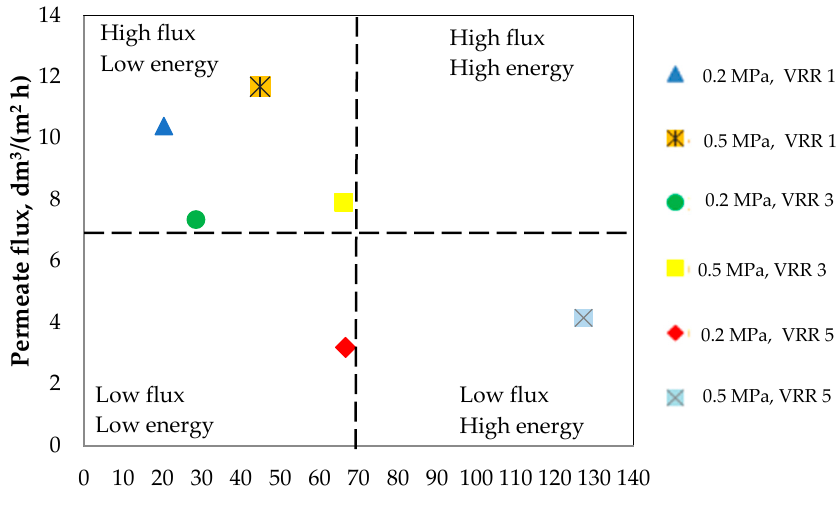
Figure 5. Relationship between the permeate flux and energy demand at different working conditions (transmembrane pressure and volume reduction ratio).